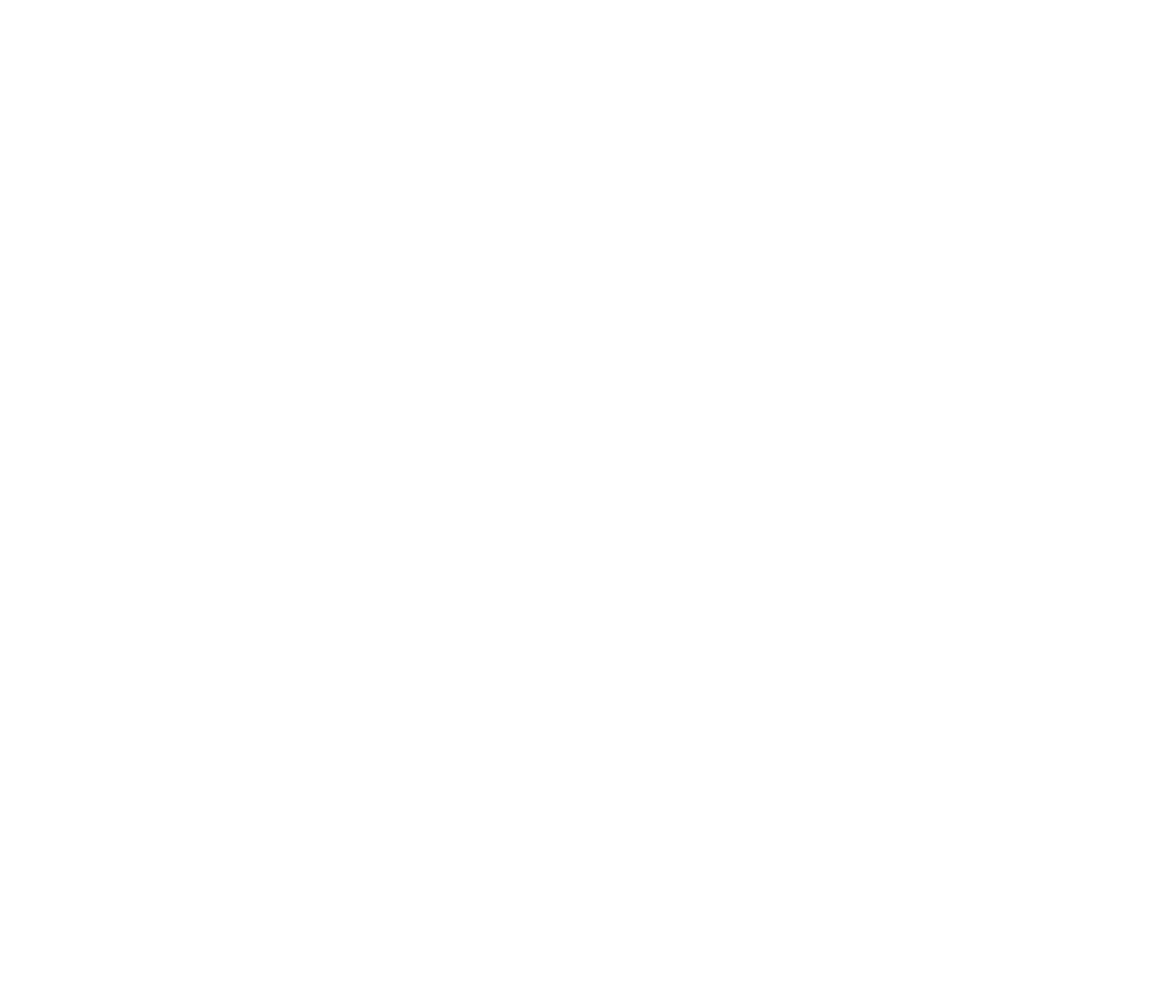
Frontiers in Marine Science |